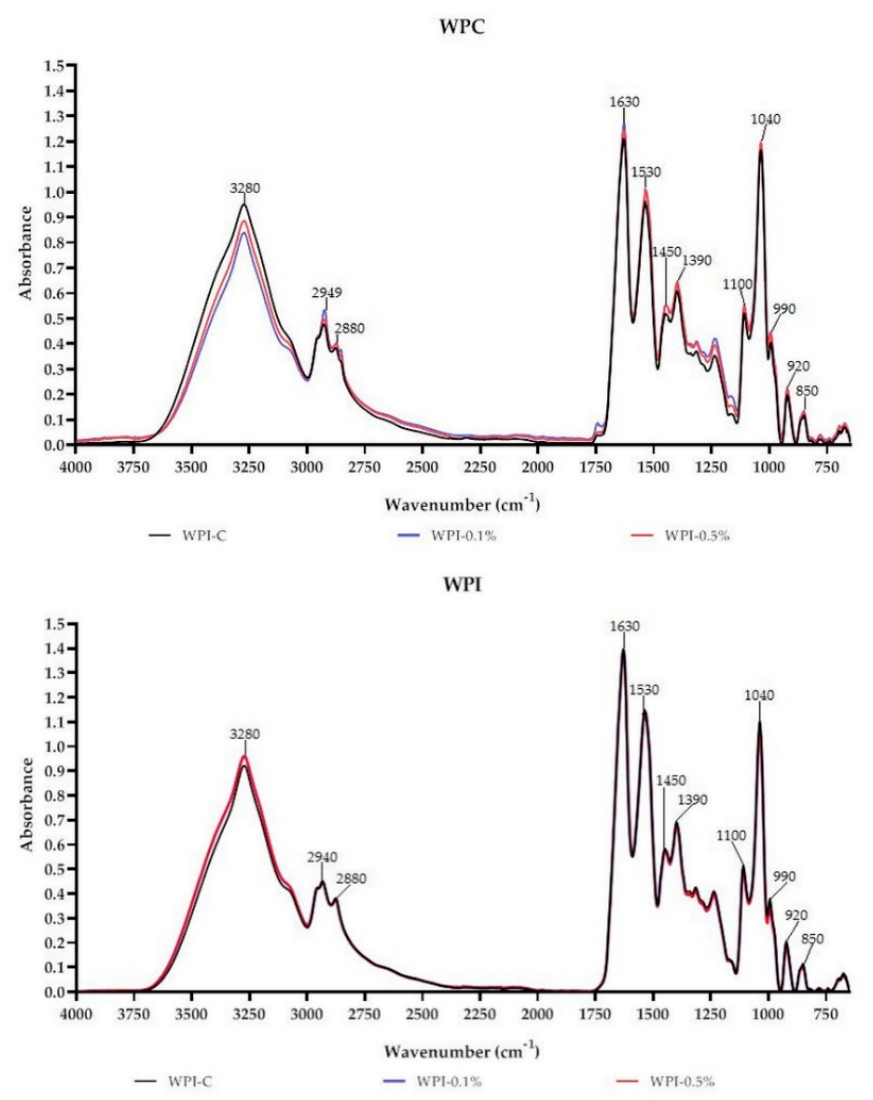
Figure 3. FT-IR spectra of neat WPC / WPI and melanin-modified films.